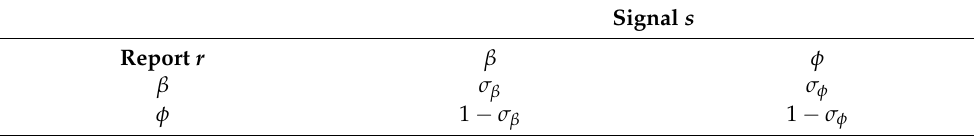
Table 1. Signals and news